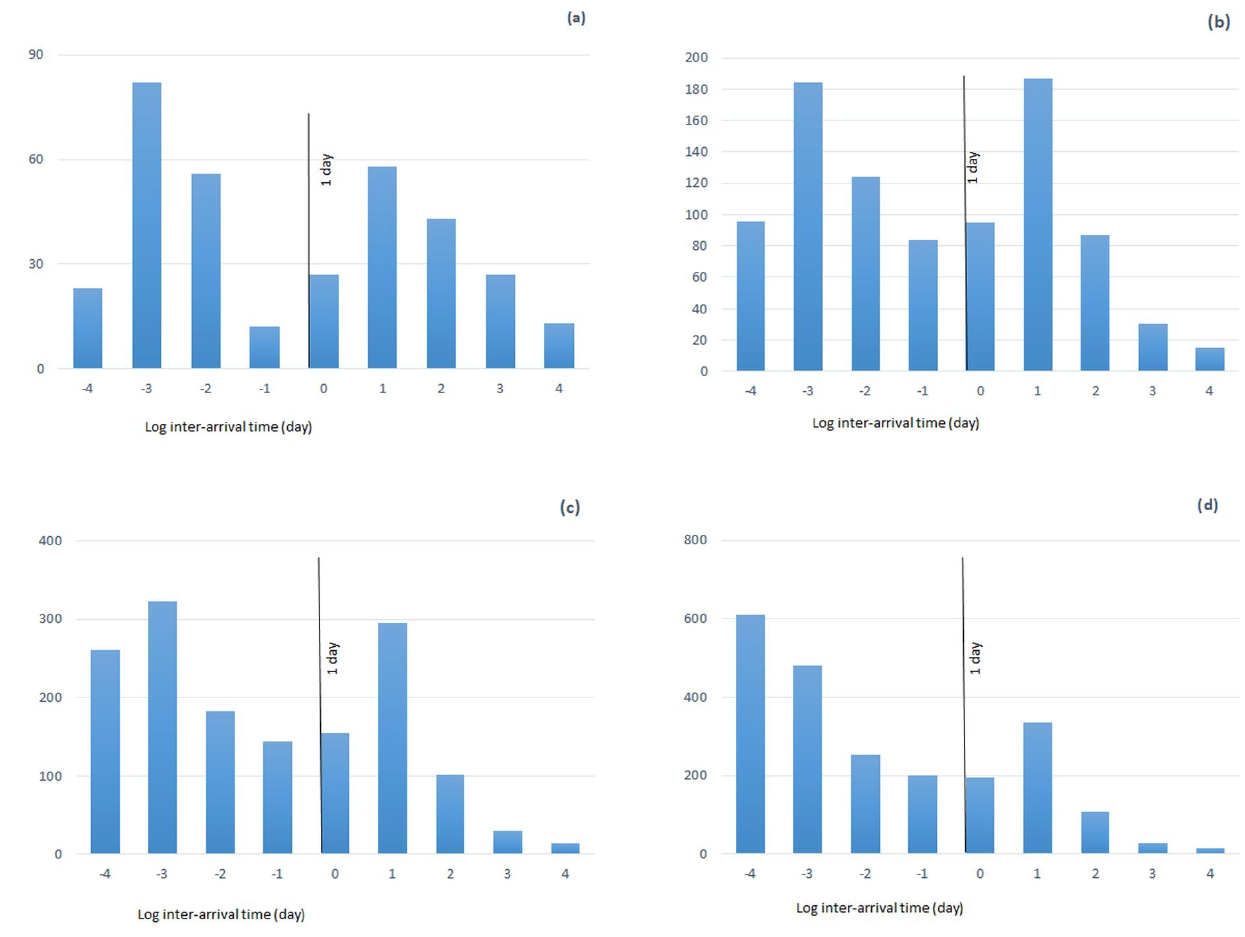
Figure 10. Histograms of the log inter-arrival time of CF VTs: (a) for M d > 0.5, (b) for M d > 0.0, (c) for M d > − 0.5, and (d) for M d > −